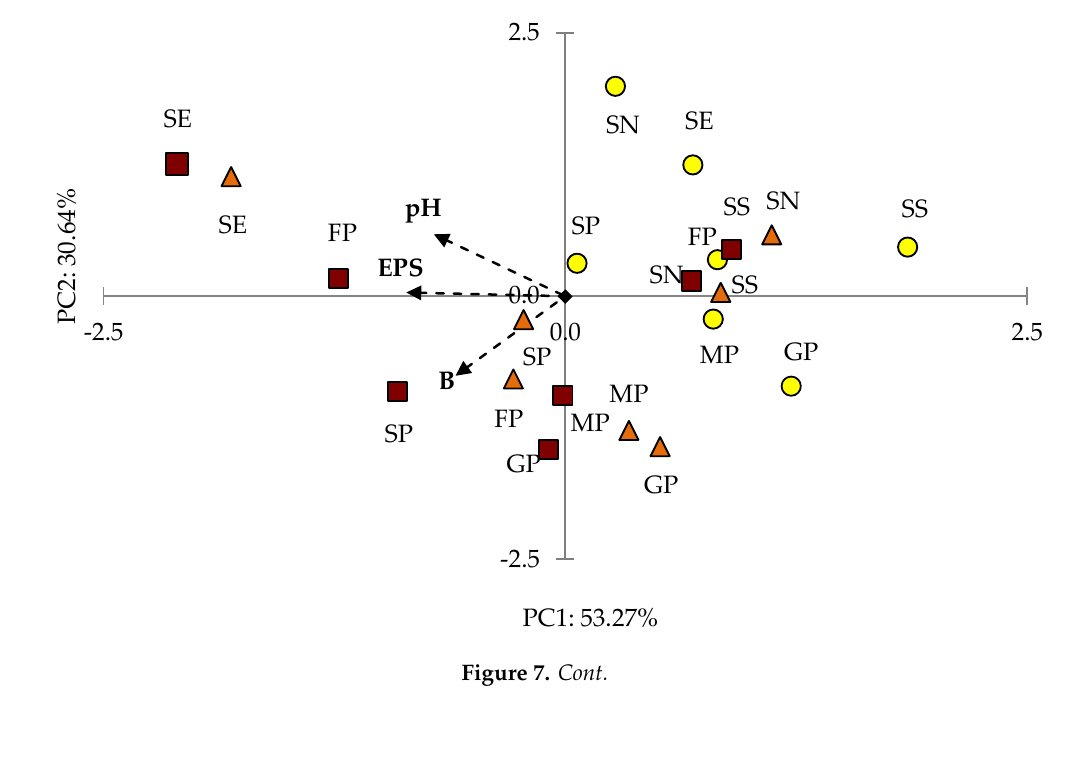
Figure 7. Figure 7. Cont.